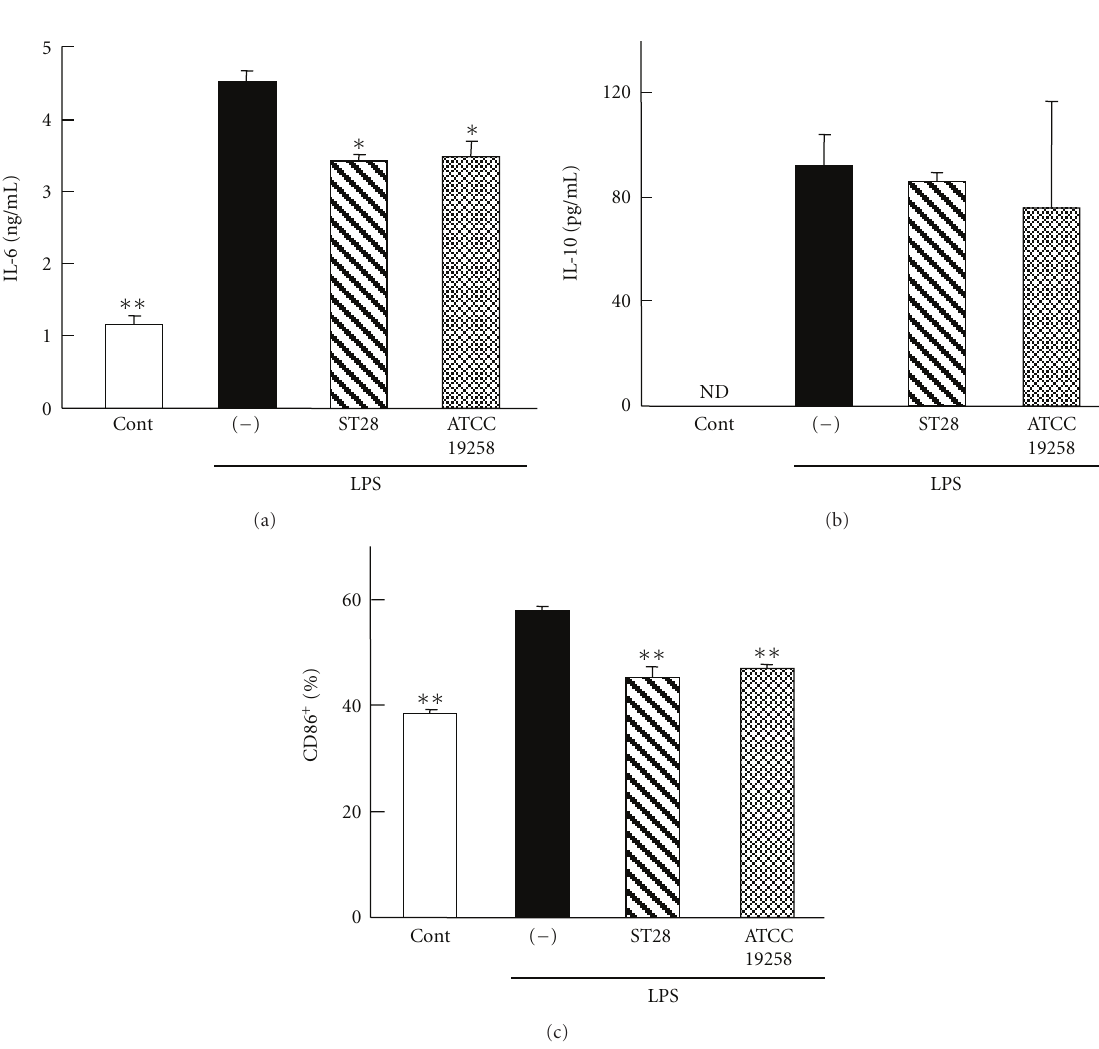
Figure 5: E ff ects of S. thermophilus ST28 on the production of IL-6 (a) and IL-10 (b) and the percentage of CD86 + cells (c) in bone marrow dendritic cells (BMDC). LPS-matured BMDC were incubated in the absence ( − ) or presence of ST28 or ATCC 19258 and assayed for concentrations of IL-6 (a) and IL-10 (b). CD86 + cells were analyzed by flow cytometry (c). BMDCs without LPS activation were used as controls (Cont). ∗∗ P < 0 . 01, ∗ P < 0 . 05 (( − ) versus Cont, S. thermophilus ST28, or S. thermophilus ATCC 19258). ND, not